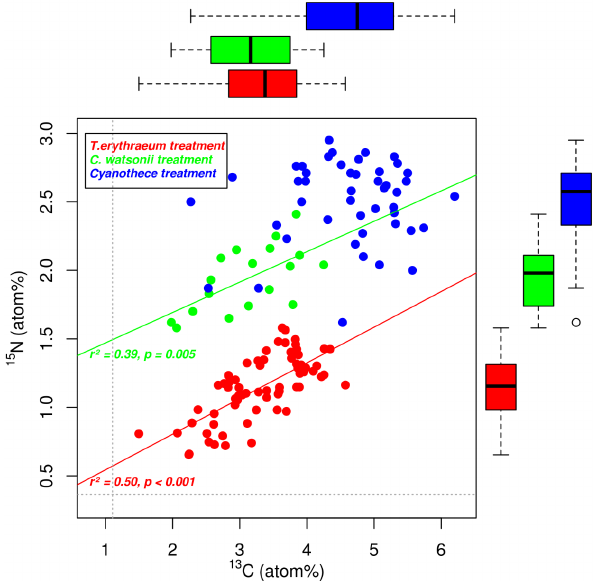
Figure 6. Box-plot of 15 N-enrichment measured in diatoms, Syne- chococcus , small eukaryotes and bacteria in the control (C), T. ery- thraeum (TR), C. watsonii (CRO) and Cyanothece (CYA) treat- ments. Red dots indicate the average values. Blue dotted lines de- pict the natural 15 N abundance. ∗ and ∗∗ depict significant enrich- ments in diazotrophs treatments compared to the control treatment (unpaired Mann–Whitney–Wilcoxon test) at 95 and 99% levels of confidences,